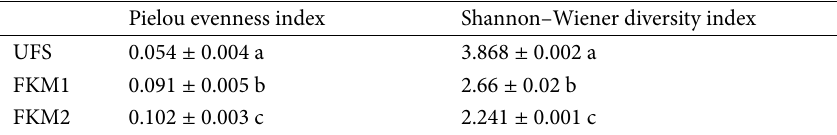
Table 3 The diversity index of bryophytes (mean ± standard deviation) in the forest within the sinkhole (UFS) and in the forests on the plateau surface (FKM1 and FKM2). Pielou evenness index